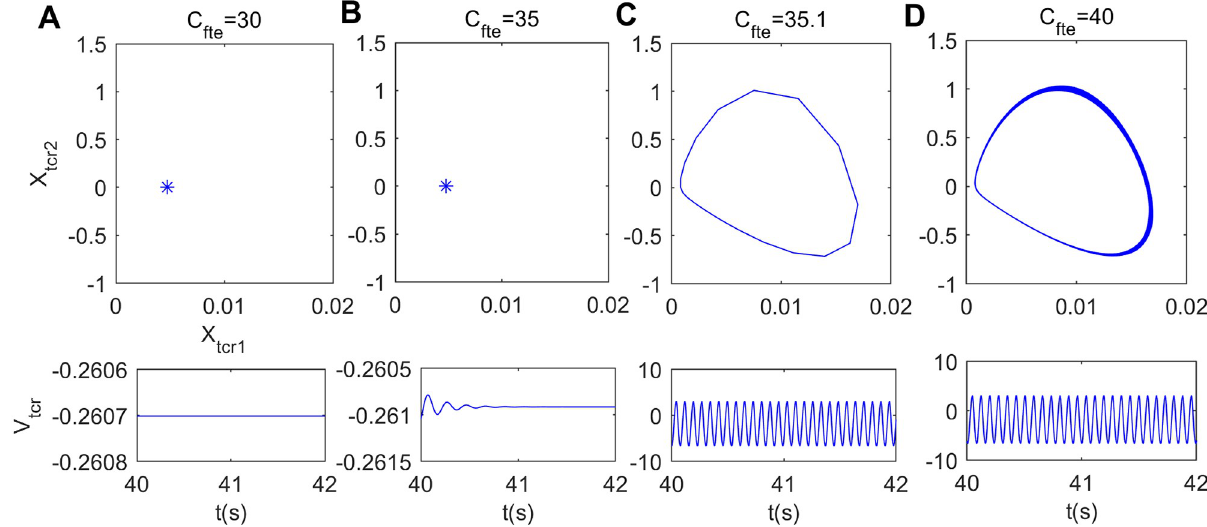
Fig 4. Phase diagrams (top panels) and the corresponding time series diagrams (bottom panels) of the thalamic module. (A) C 35, (C) C = 35.1, (D) C = 40. fte fte